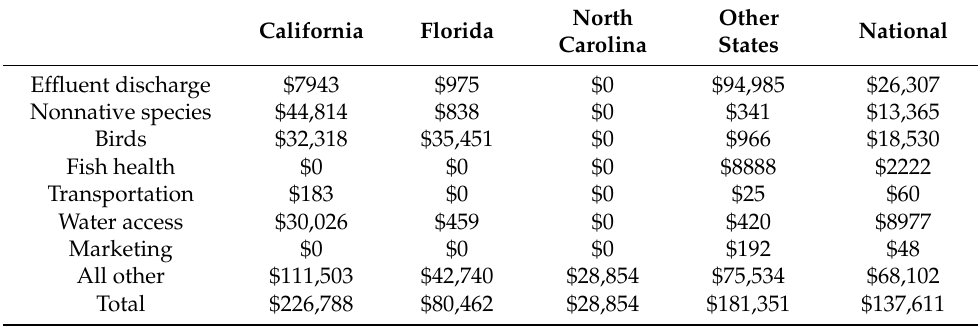
Table 9. Total regulatory cost by regulatory category by state ($/farm).